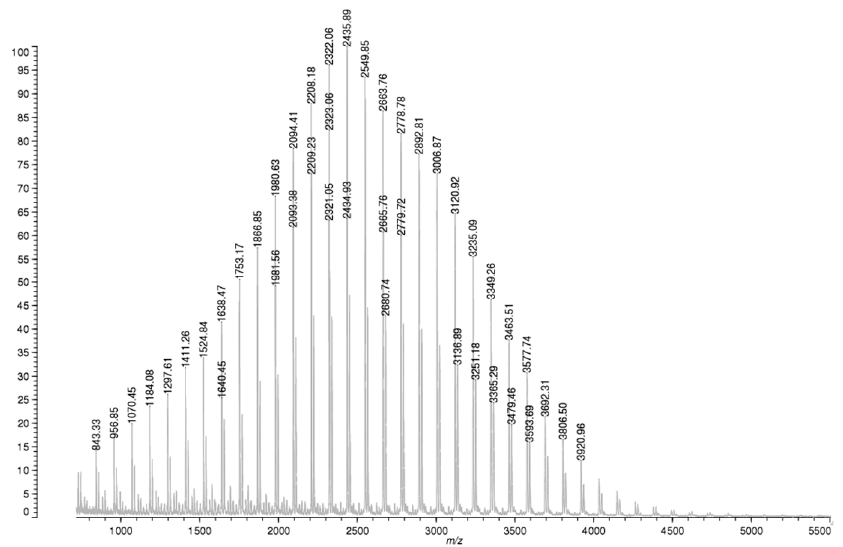
Figure 7. MALDI-TOF spectrum of PAGE-diol (7) prepared with K-DPG/L.